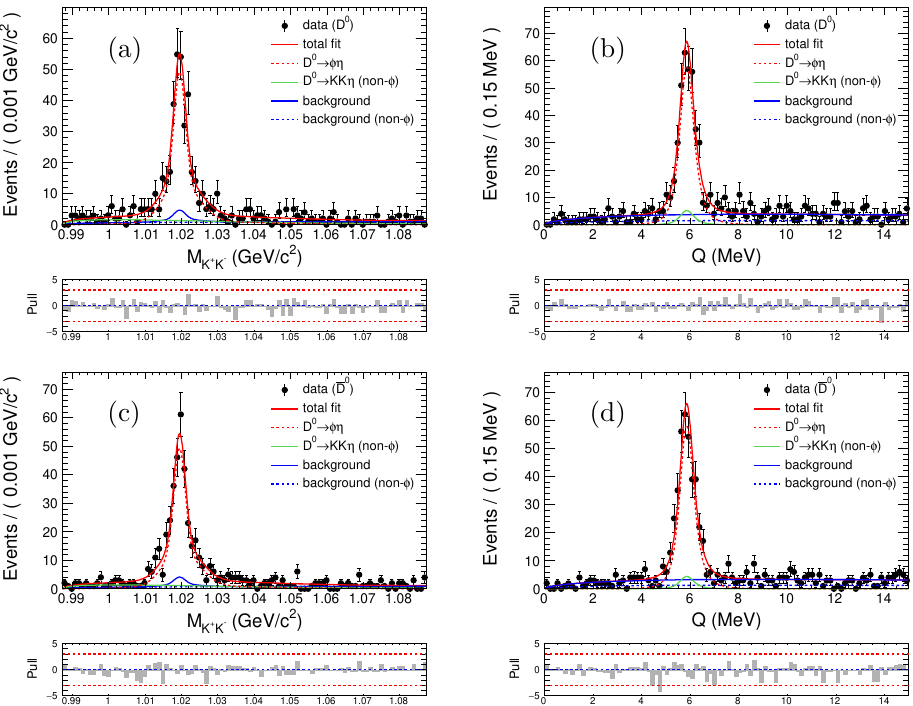
(left) and Q (right) of the two-dimensional ( M Figure 6 . Projections in M K + K − for D 0 → φη (top) and D 0 → φη (bottom). In both cases, the M the Q signal region ( | Q − 5 . 86 | < 0 . 8 MeV), and the Q projection corresponds to the M region ( | M − m φ | < 0 . 01 GeV/ c 2 K + K −